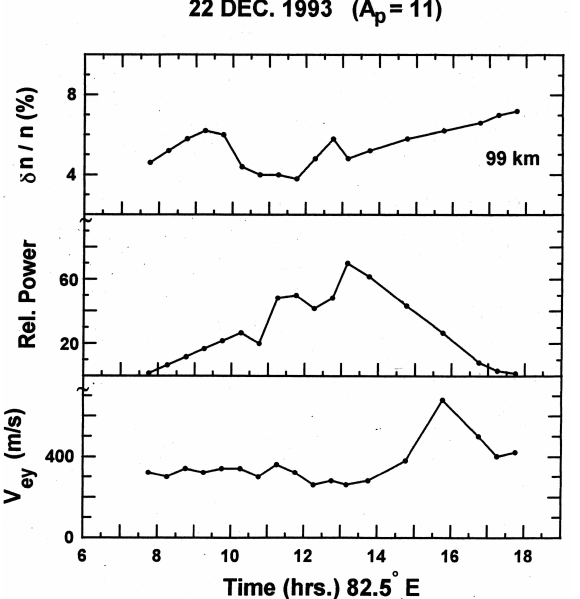
Fig. 7. Daytime variation of corrected V ey , relative power and δ n/n at 99km on 22 December 1993.